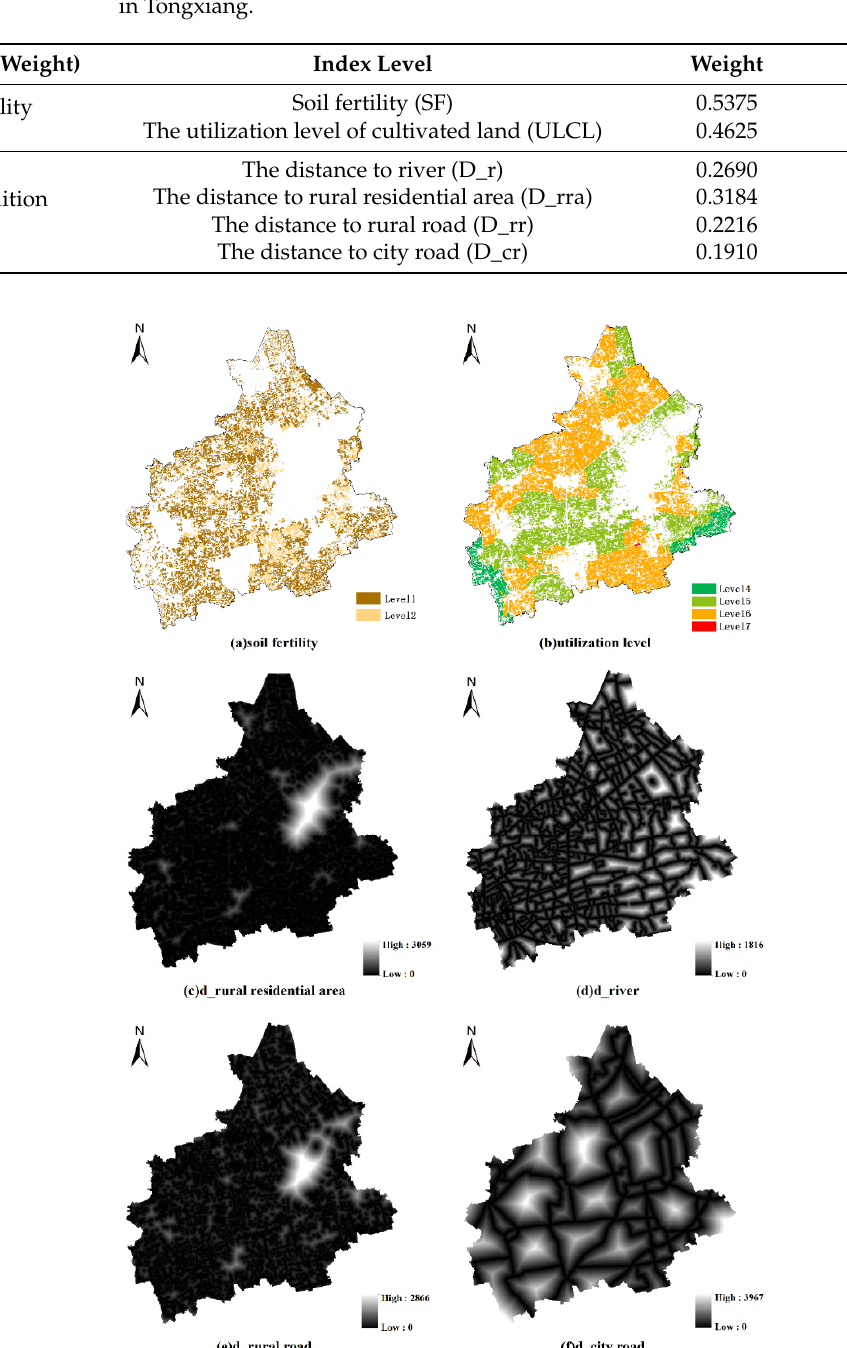
Figure 3. Map of cultivated land condition factors in Tongxiang city: ( a ) soil fertility; ( b ) utilization level of cultivated land; ( c ) distance to rural residential area; ( d ) distance to river; ( e ) distance to rural road; ( f ) distance to city road.